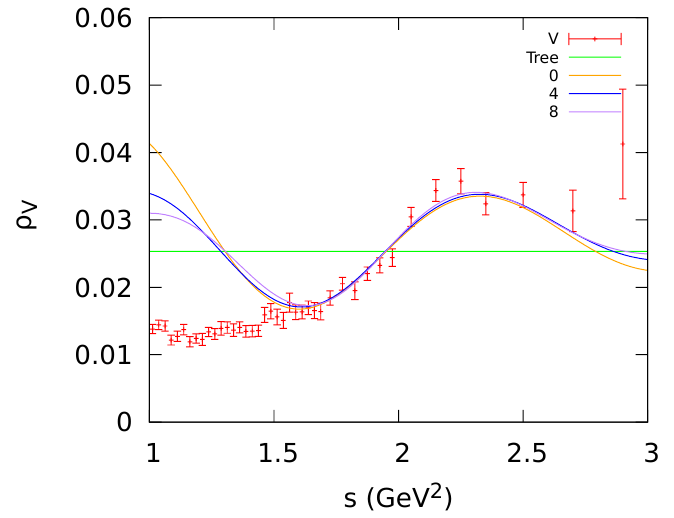
( s ) , fitted above 1.55 GeV 2 with the ansatz (4.2), for different Figure 8 . Vector spectral function ρ V values of λ = 0 , 4 , 8 , compared with the data points V